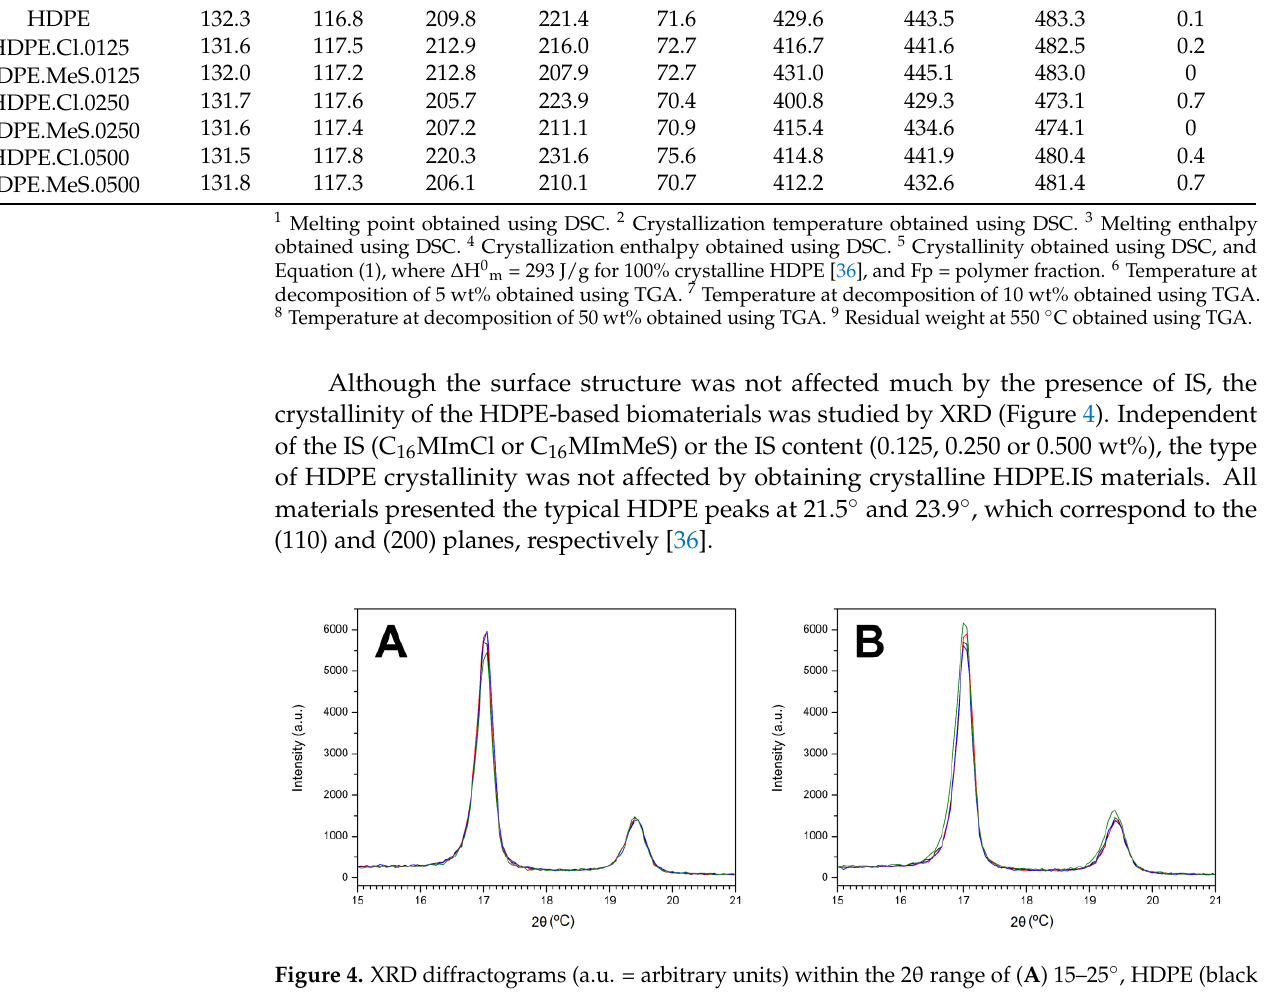
Figure 3. AFM images of HDPE, HDPE.Cl.0500, and HDPE.MeS.0500 (Ra = arithmetic mean roughness). Table 1. Thermal Properties of HDPE Films. Figure 2. SEM micrographs of ( A ) HDPE, ( B ) HDPE.Cl.0500, and ( C ) HDPE.MeS.0500 (scale bar = 1 μm).